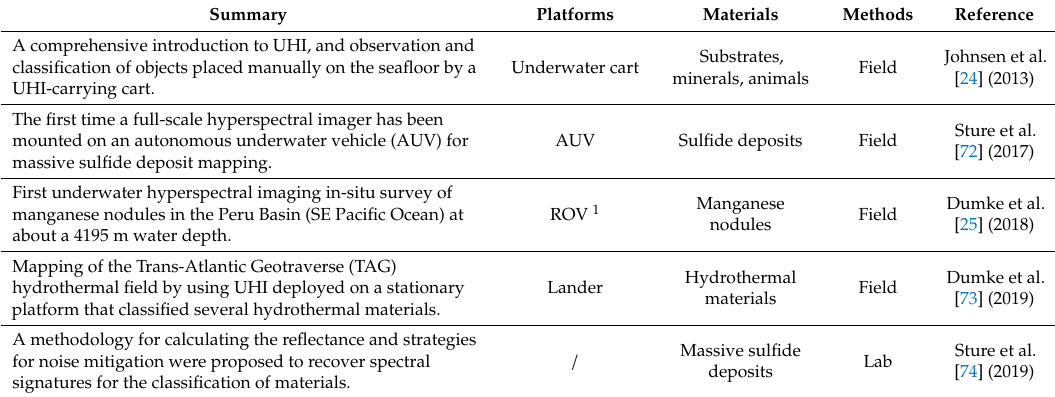
Table 2. Examples of marine mineral exploration conducted by using UHI.